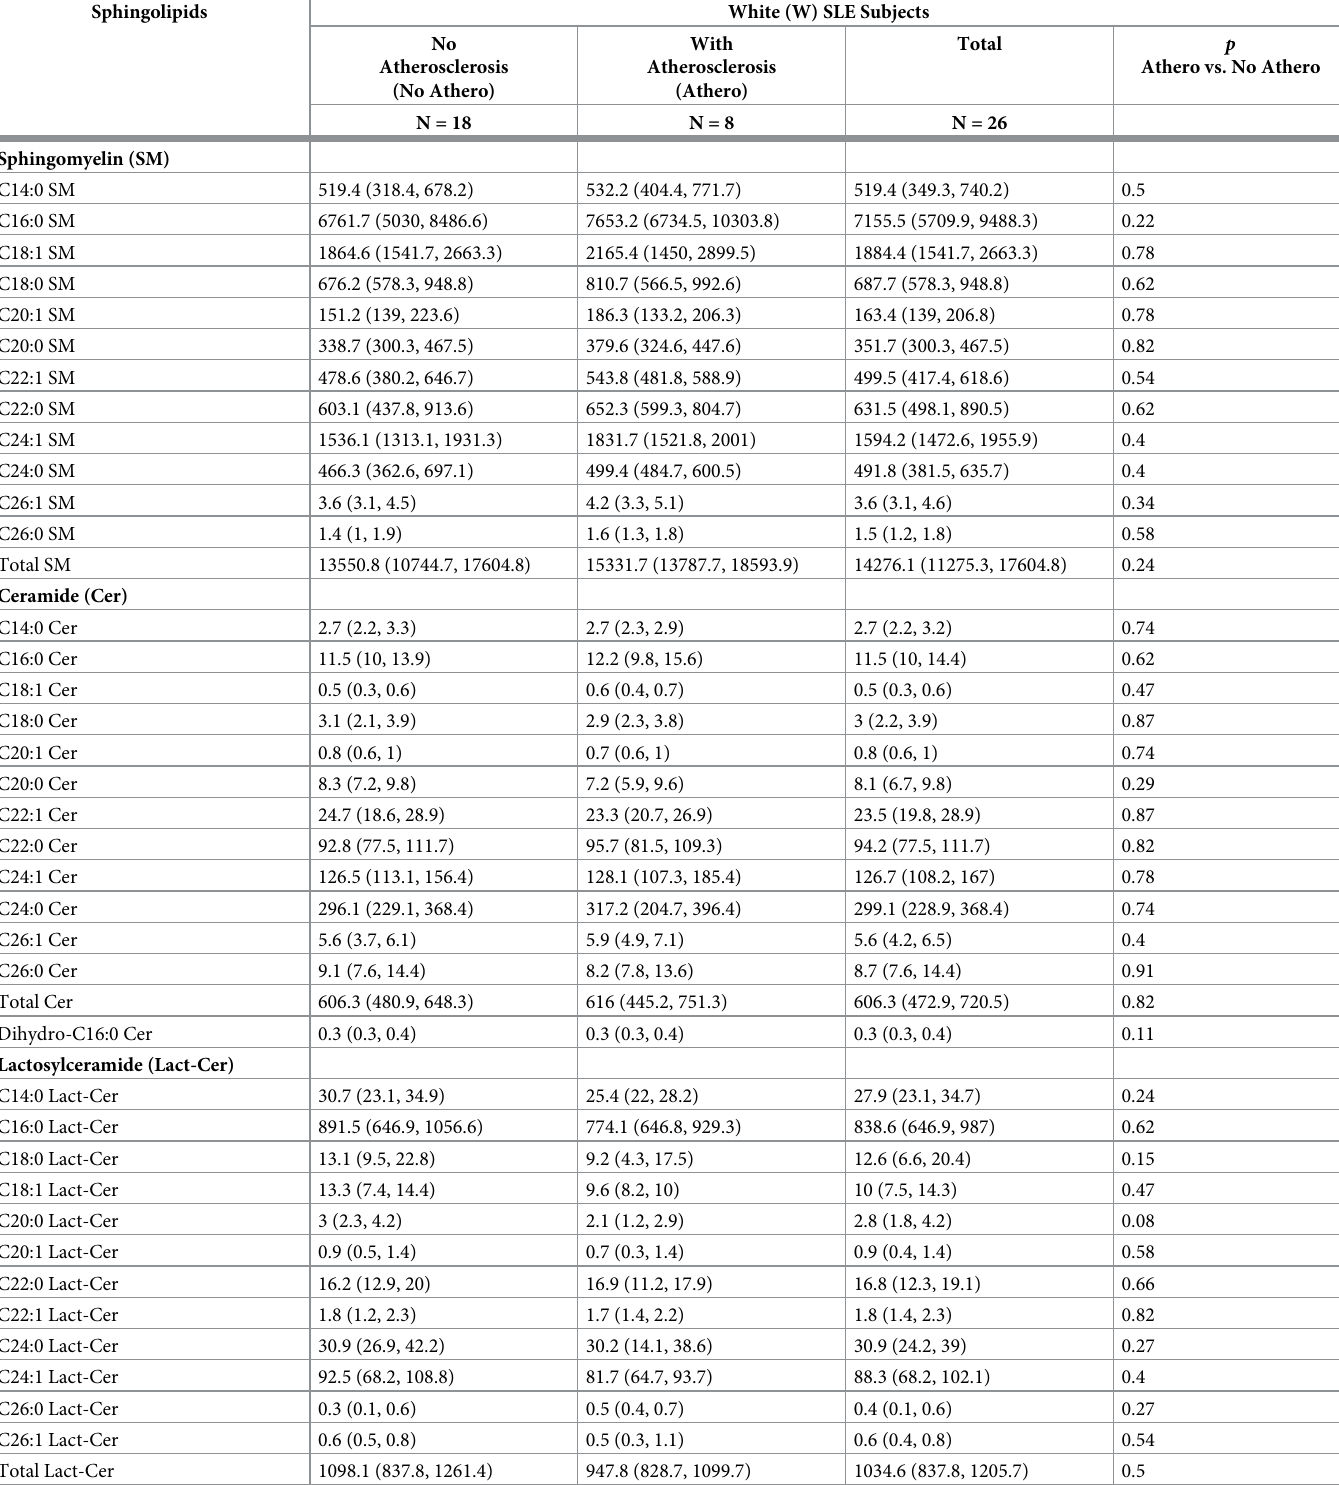
Table 4. Sphingolipid concentration in plasma of White SLE patients with atherosclerosis compared to sphingolipid concentration in plasma of White SLE patients without atherosclerosis. Sphingolipids White (W) SLE